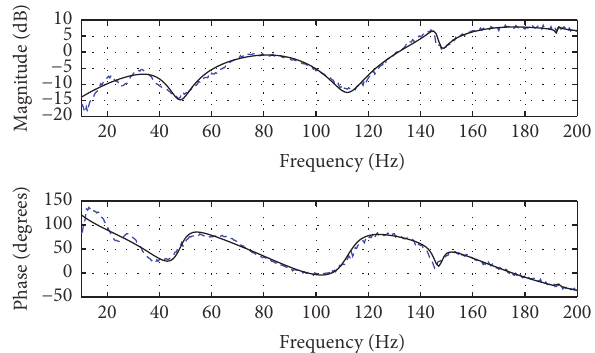
Figure 6: Frequency response curves of VA25 experiment model and identification system